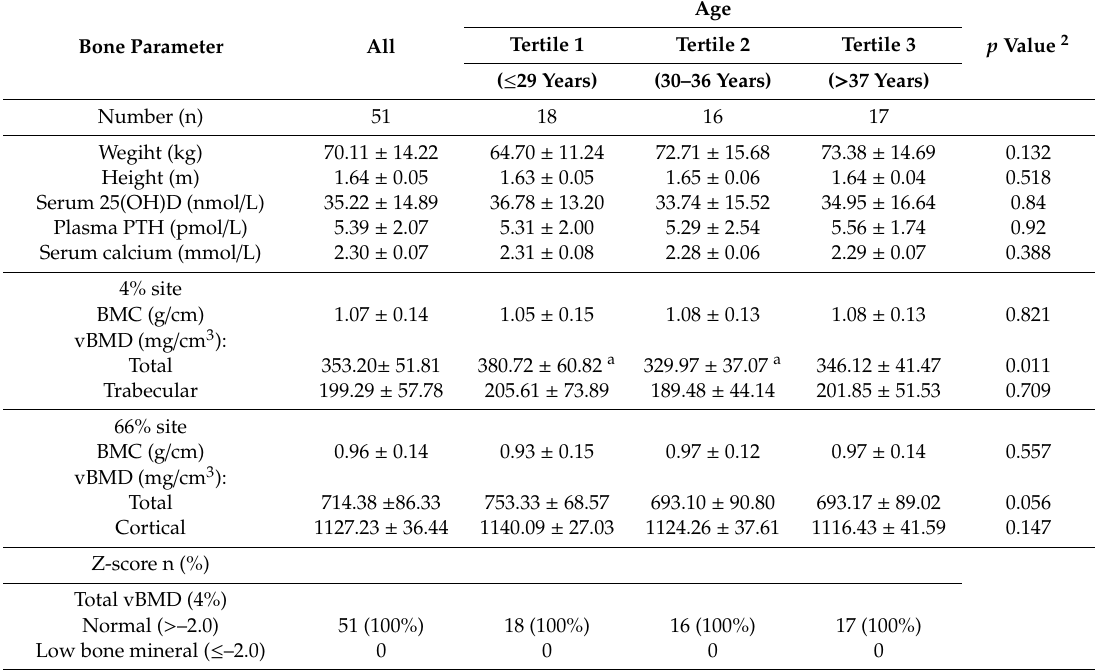
Table 2. Radial bone densitometry assessed by peripheral Quantitative Computed Tomography (pQCT) of Brazilian women living in England by age tertiles ( n = 51) 1